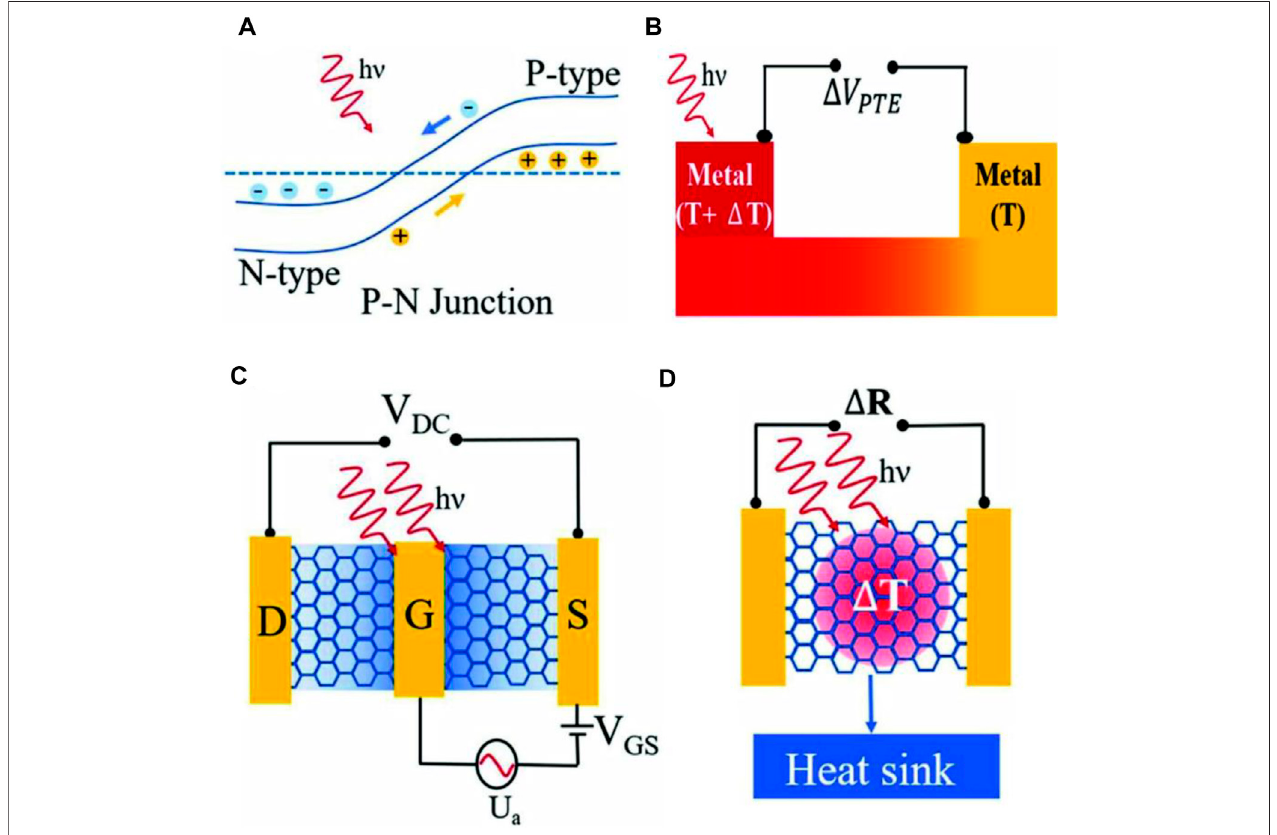
FIGURE 2 | A schematic representation of photodetection mechanisms, (A) Photovoltaic effect (Qiu and Huang, 2021), (B) Photo-thermoelectric effect (Qiu and Huang, 2021), (C) Bolometric effect (Qiu and Huang, 2021), and (D) Plasma wave assisted mechanism (Qiu and Huang, 2021); Reproduced with permission from (Qiu and Huang, 2021).